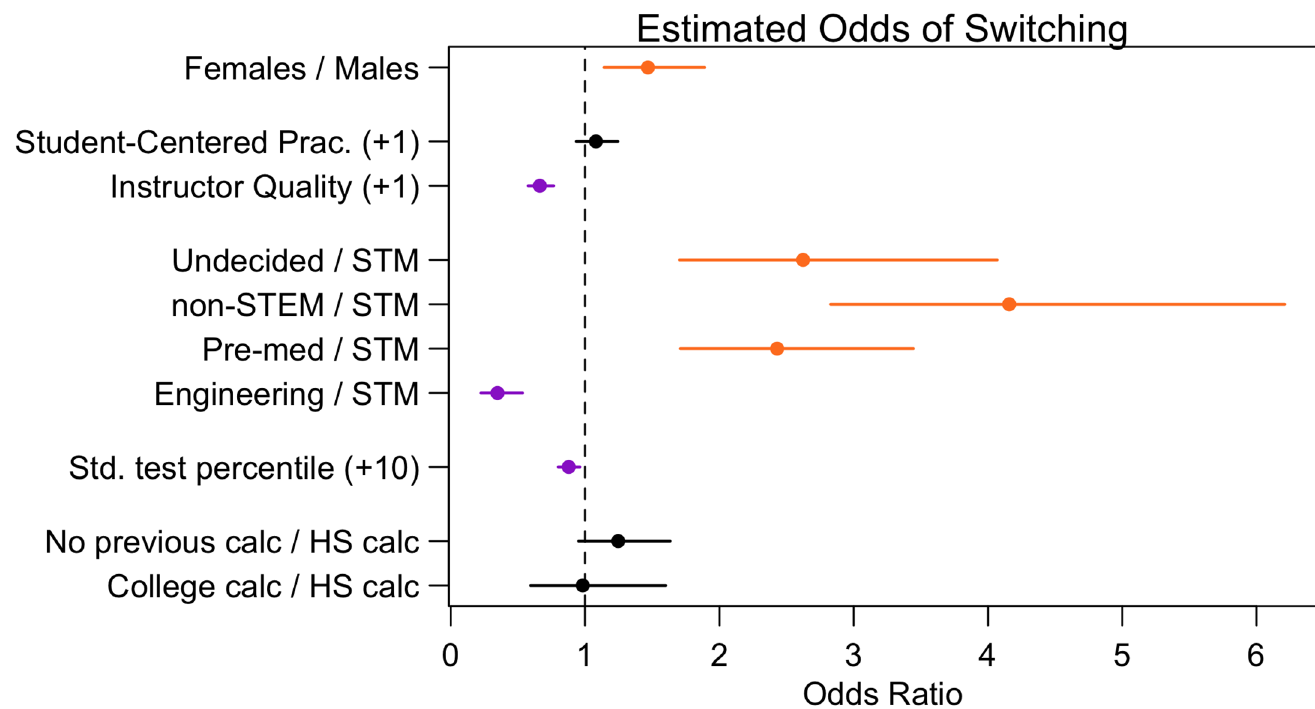
Fig 2. Odds ratios of switching for student attributes. The circle represents the odds ratio estimate and the bars represent the 95% credible interval. The continuous variables noted with (+x) on the left compare a student who reported x-points higher than another student. Labels of the form A / B correspond to the ratio of the odds of switching for a student of type A to the odds of switching for a student of type B. Variables associated with decreased likeliness and increased likeliness of switching are highlighted in purple and orange, respectively. [N =